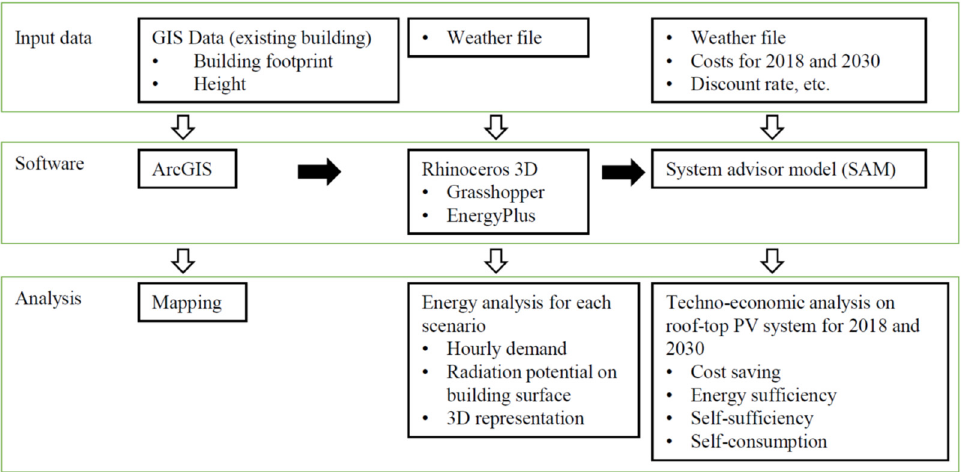
Figure 1. Evaluation workflow for waterfront building environmental energy analyses.